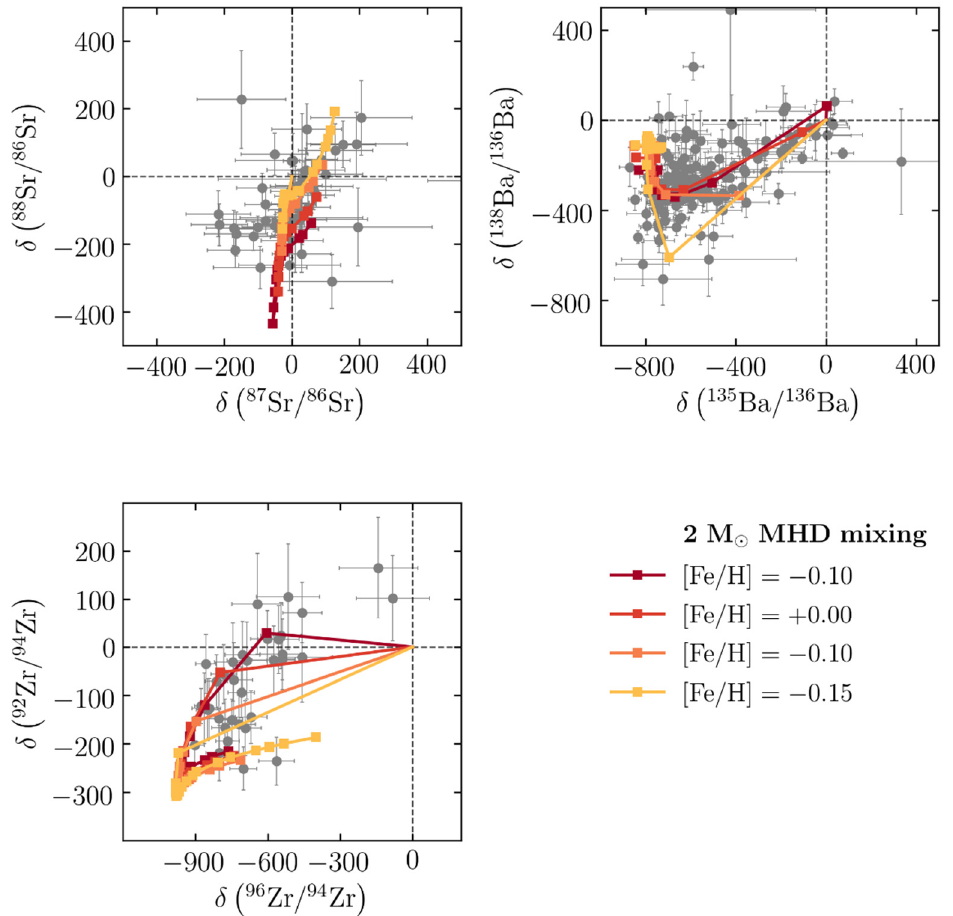
Figure 1. Comparison between s-process models for AGB stars and presolar MS SiC grain data for Sr, Ba, and Zr. Isotopic ratios are expressed as part-per-mil deviations ( δ ) from the terrestrial value. Models are from Ref. [28] and refer to 2 M ⊙ AGB stars at different metallicities, where magneto- hydrodynamic (MHD) processes induce the formation of the 13 C pocket. Abundances are computed in stellar winds by considering 5% of mixing due to C-rich material transported to the envelope by magnetic blobs (see Ref. [28] for more details). Grain data are from the PDG database [19]. The picture is modified after Palmerini et al. (2021) [28].